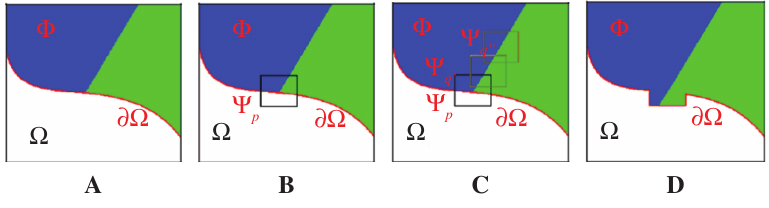
Figure 4. Structure Propagation by Patch-Based Synthesis. (A) Original Image I , with Ω as Region to Fill (Target Region), ∂Ω as the Target Region Boundary (Fill Front), and φ = I – Ω as Source Region. (B) ψ (C) The Probable Match of ψ Filled from the Corresponding Best Matching Patch